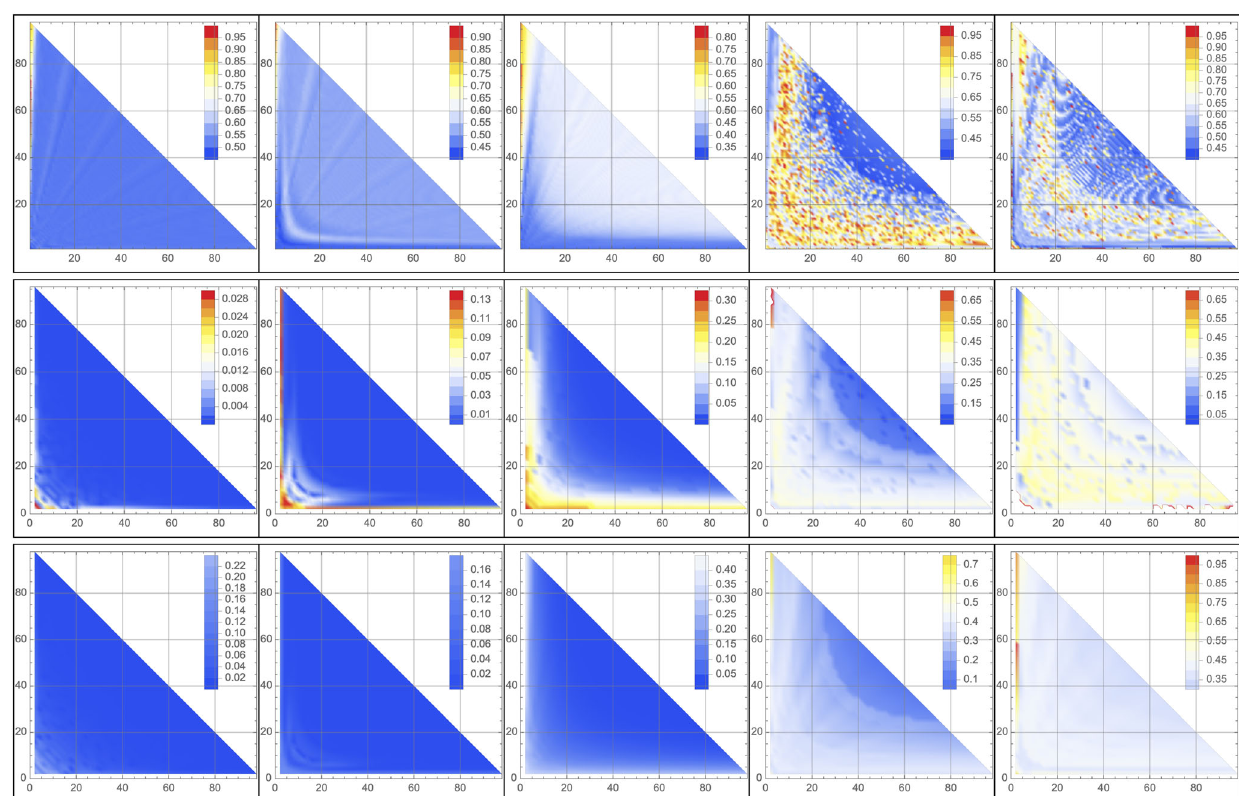
Fig. 6 Values of the cost functions ℵ QC and ℵ QCSL as a function of t 1 , t 2 . In all panels, the scale bar refers to the values of the cost functions ( ℵ QC or ℵ t t t t QCSL ) as a function of 1 and 2 , where 1 , 2 are the free evolution times of the nanoparticle before and after the laser grating, respectively, and they appear on the horizontal and vertical axes in all panels. The triangular area of the density plot is determined by the constraint t 1 + t 2 ≤ 100 s. The different columns correspond to fi ve different values of the mass of the nanoparticles considered, respectively, 10 7 , 10 8 , 10 9 , 10 10 , 10 11 amu. The fi rst row shows ℵ QC , i.e., how distinguishable the quantum and classical interference fi gures are (the subscript QC stands exactly for Quantum-Classical). These fi gures are obtained by choosing as the ratio between the laser energy and spot area ( E L / a L ) the value that maximizes ℵ QC in the physically feasible range between 10 − 6 and 5 J/ m 2 . For the numerical values of E L / a L employed we refer to Supplementary Fig. 2. The second row shows the values of ℵ QCSL , i.e., how distinguishable the quantum interference fi gure is from the one accounting for the Continuous Spontaneous Localization (CSL) — here the subscript QCSL stands for the Quantum-CSL comparison. These fi gures are obtained by assuming the same values of E L / a L used in the fi rst row and for a value of the CSL parameters proposed by Adler and given by λ CSL = 10 − 8 s − 1 and r c = 10 − 7 m. Finally, the third row shows the values of ℵ QCSL like in the second row where, however, the values of E L / a L used are the ones that maximize ℵ QCSL independently from the results in the fi rst row of fi gures. For the numerical values of E L / a L employed we refer the interested reader to Supplementary Fig.